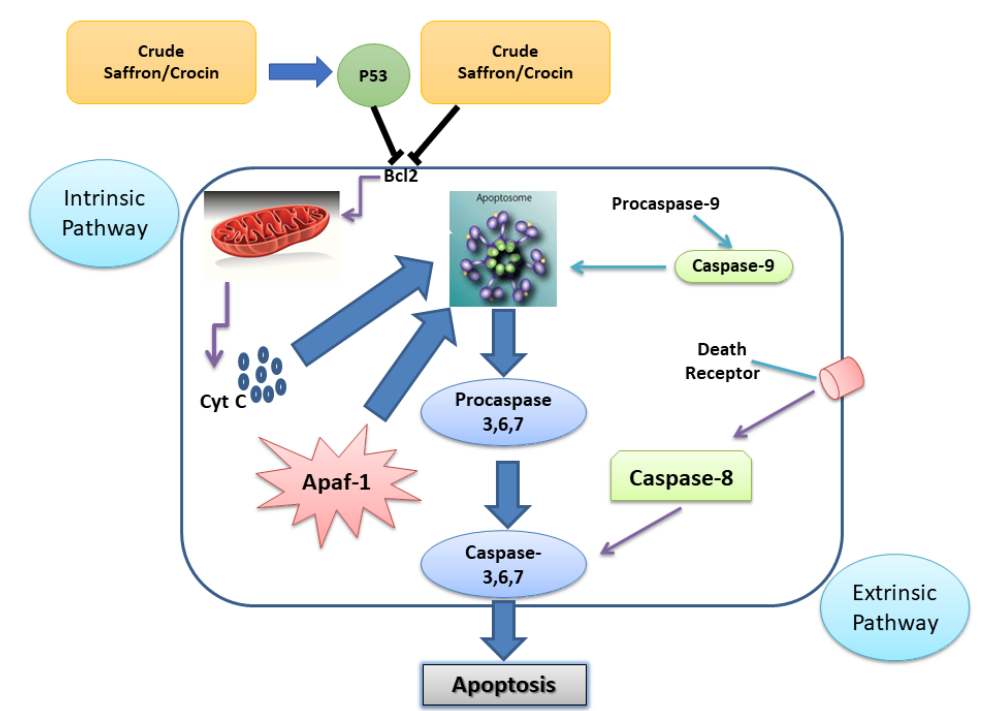
Figure 2. Mitochondrial activation of the intrinsic pathway involves the inhibition Bcl2. Cytochrome C leaking out from the mitochondria to form the complex-apoptosome, composed of caspase-9 and Apaf-1, which activates the executor caspases 3, 6, and 7. Extrinsic route implies the activation of a death receptor in the cytoplasmic membrane by means of a ligand which activates the initiator caspase-8, followed by the executor caspases 3, 6, and 7. The activation of the executor caspases causes morphological changes related to the apoptotic